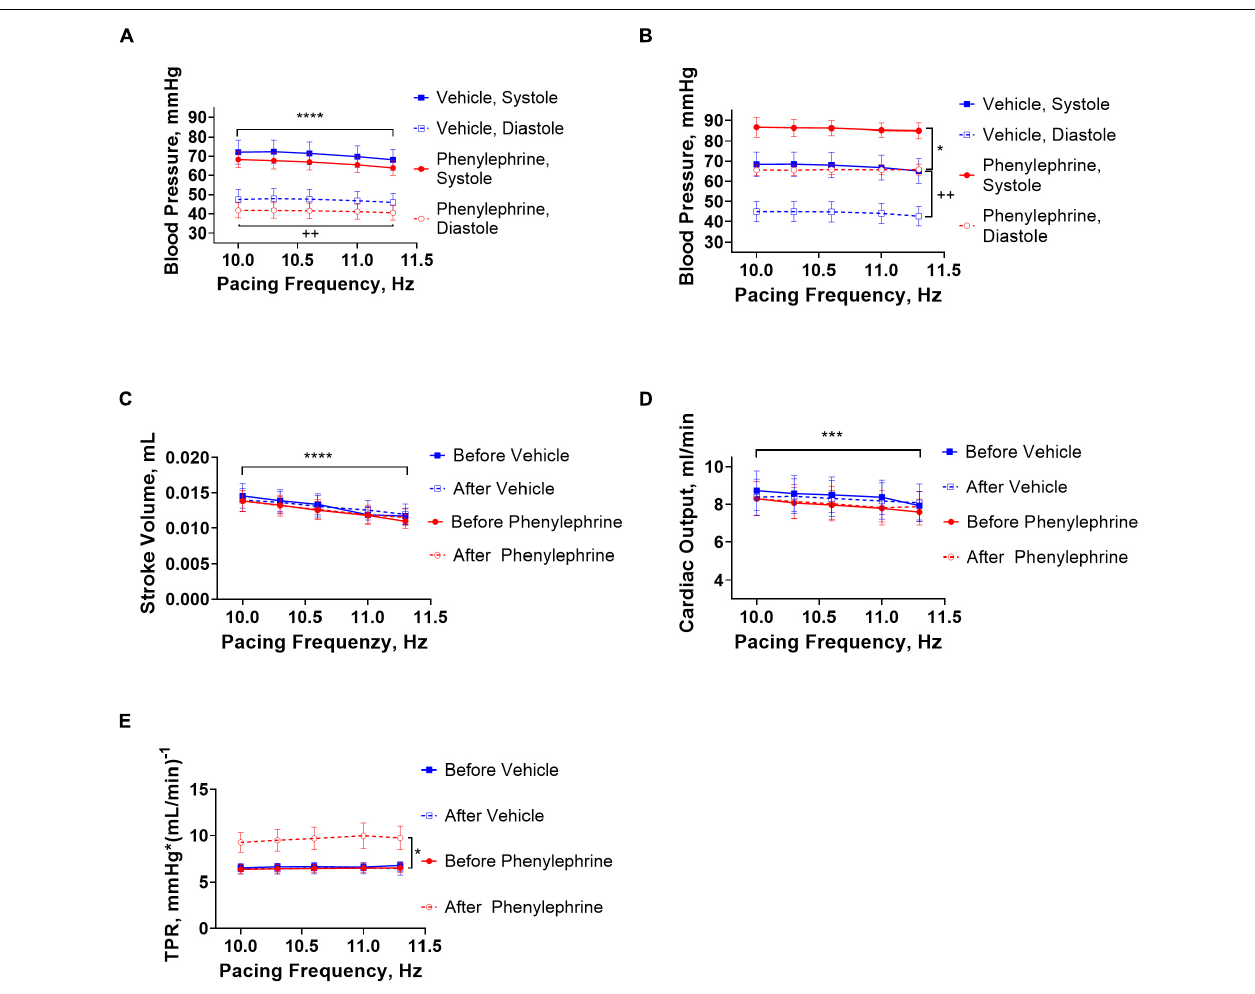
FIGURE 5 | (A) During the first pacing session, prior to administration of vehicle or phenylephrine, blood pressure was decreased with increasing pacing frequencies in both groups (**** P < 0.0001 for systolic pressure and ++ P = 0.0028). (B) During the second pacing session after administration of phenylephrine, blood pressure did not change with increasing pacing frequencies, but elevation of blood pressure compared to vehicle group was maintained (* P = 0.028 for systolic blood pressure and ++ P = 0.0064 for diastolic pressure). (C) Stroke volume decreased significantly with increasing pacing frequencies (**** P < 0.0001). (D) Cardiac output was also affected with increasing pacing frequencies (*** P = 0.0002). (E) Total peripheral resistance did not change with increasing pacing frequencies, but the phenylephrine-induced increments in total peripheral resistance were maintained during the second pacing session compared to the vehicle group (* P = 0.04). Data were compared with two-way ANOVA, n =